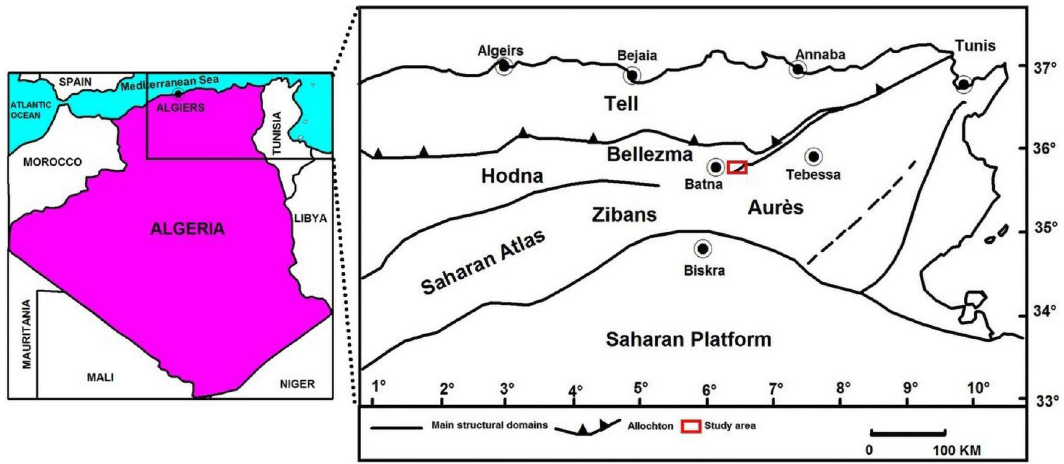
Fig. 1 Situation of the study area [10] (Missoum